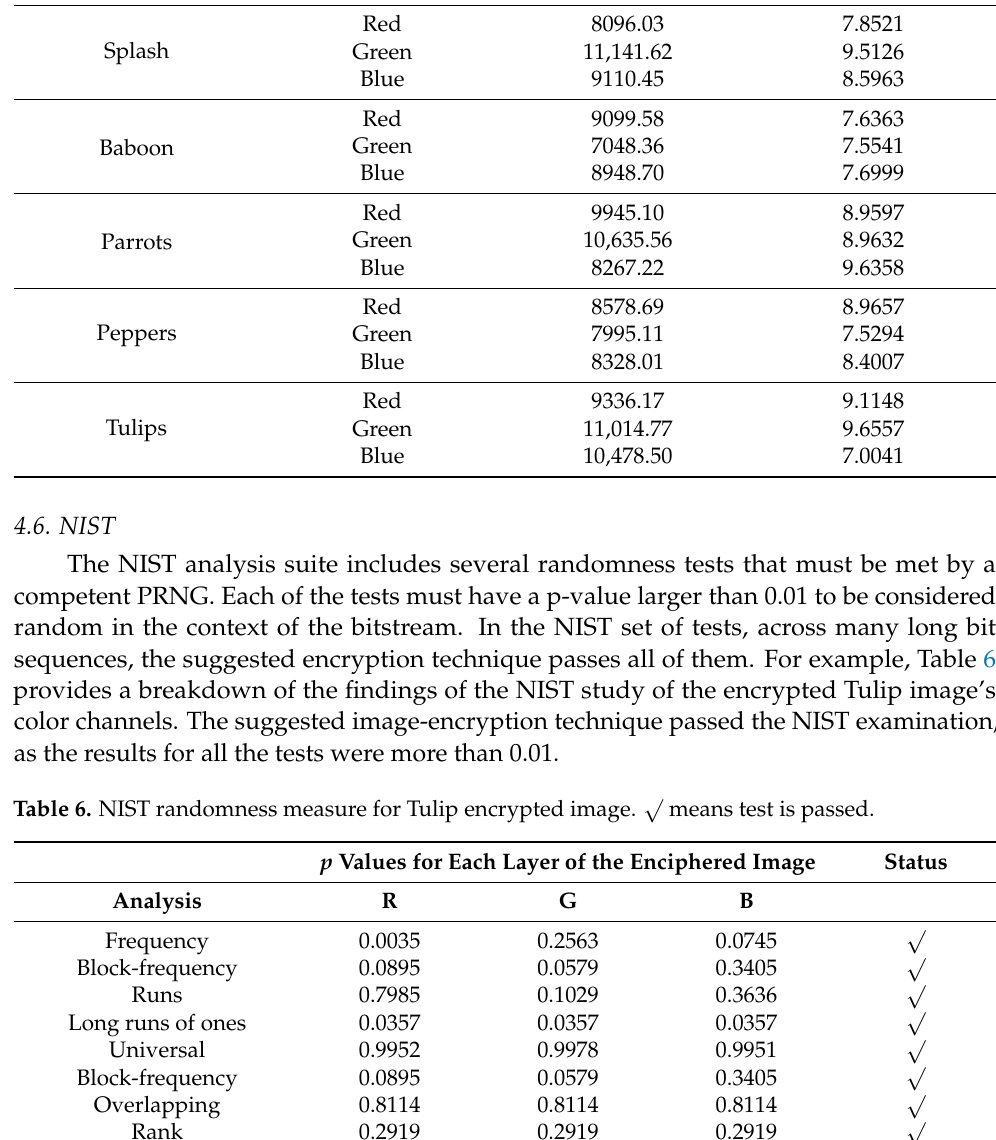
Table 5. MSE and PSNR analysis for some standard image layers. Image